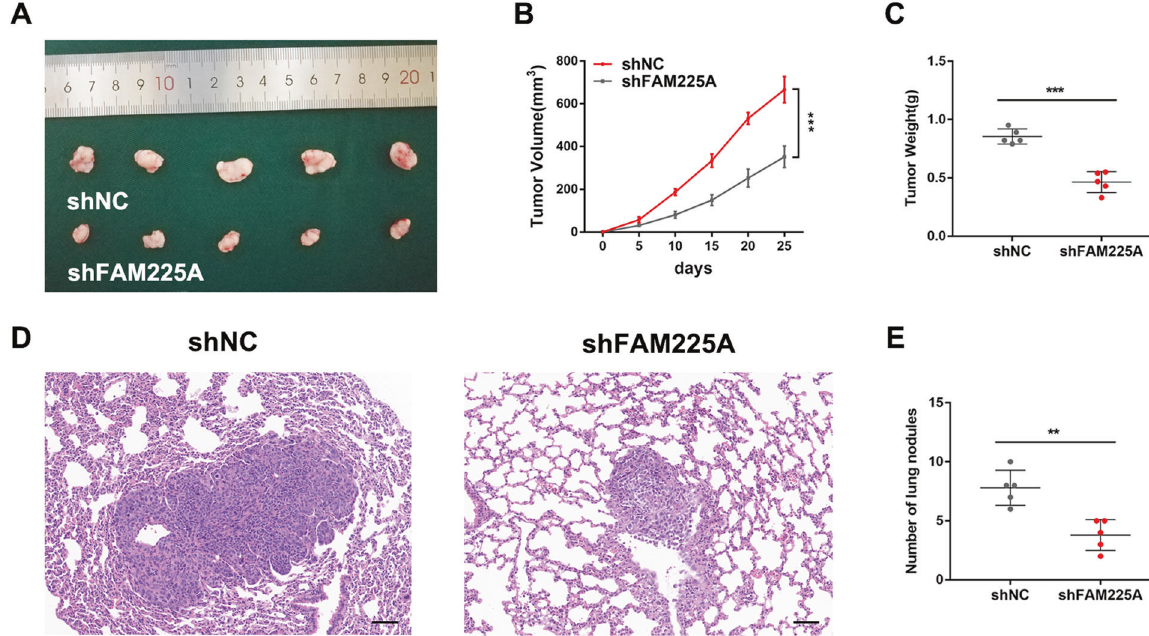
Fig. 3 Knockdown of FAM225A inhibits GC tumor growth and metastasis in vivo. A Tumor tissues harvested from shFAM225A and shNC groups of female nude mice. B Tumor volumes in both groups were measured every 5 days. C Tumor weight in different groups. D , E HE staining of specimen to show lung metastasis in shFAM225A and shNC groups (scale bar: 50 μ m). p values were obtained by Student ’ s t test ( C , E ) or ANOVA ( B ). Data are presented as means ± SD. ** p < 0.01, *** p <